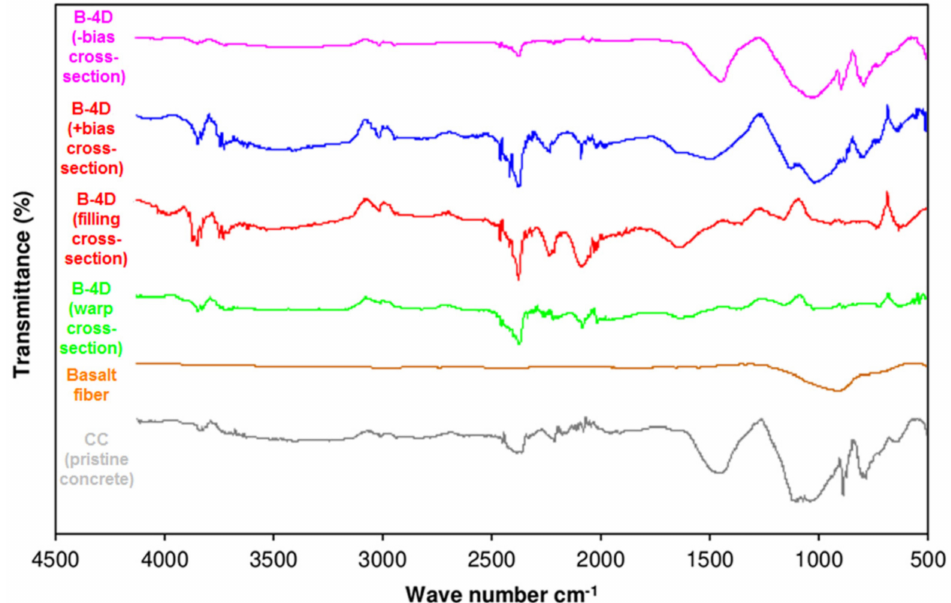
Figure 16. Fourier transform infrared spectra of CC (pristine concrete), basalt fiber and B-4D concrete composites. In the FTIR spectrum of the B-1D (warp cross-section), B-2D (filling cross-section) and B-4D (warp cross-section) basalt/cementitious concrete composites (Figure 15), a common signal on all developed structures was detected. The peak observed between 3500 and 3000 cm − 1 bands may be attributed to the deformation vibrations of H 2 O, polycarboxylate, -Si-OH and -Ca-OH groups [106]. In the 3000–2850 cm − 1 band spacing, the deformation vibrations of -CH2-CH- (aliphatic) groups were found. On the other hand, the signal between 2300 and 2200 cm − 1 corresponded to − C ≡ N (nitryl) group. The signals between 1600 and 1300 cm − 1 were attributed to stretching vibrations of the -C=C-, -C=O and -C=N groups. The signal observed between 1100 and 800 cm − 1 was assigned to the Si-O single-bond stretching